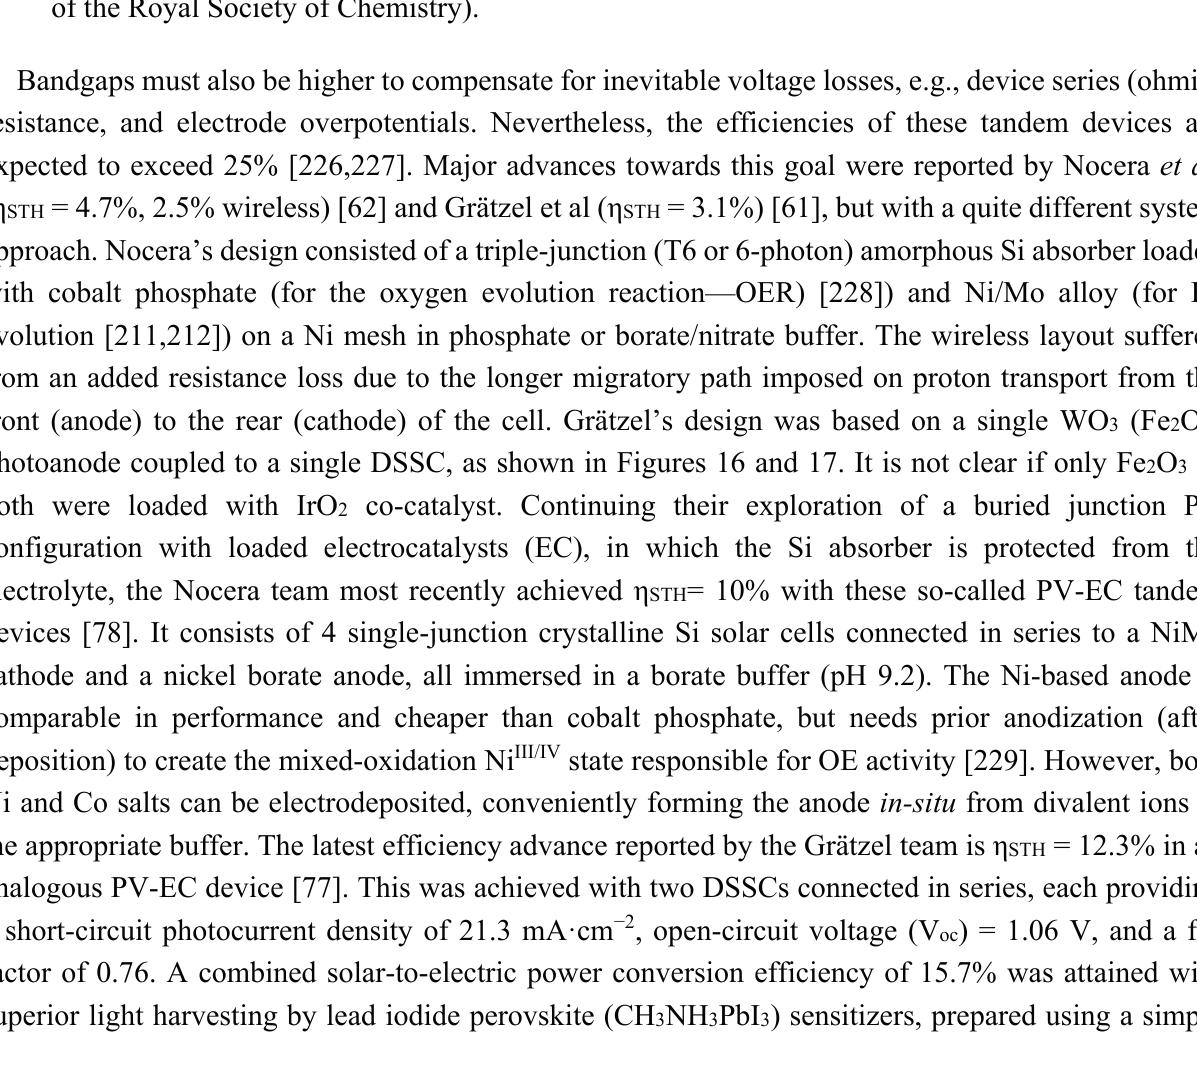
Figure 18. Bandgaps and band edge positions of representative semiconductors in relation to the redox potentials for water splitting at pH = 0. (Reproduced from [220] with permission of the Royal Society of